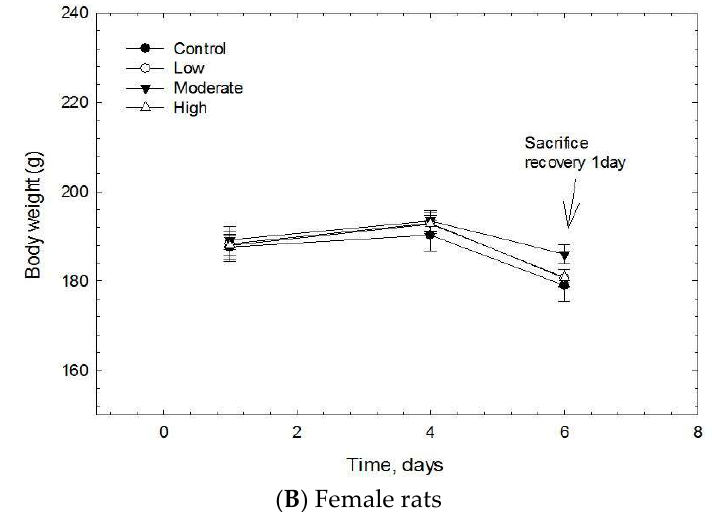
Figure 5. Changes in bodyweights of male rats during 5 days CNF exposure period and at 21 days post-exposure. ( A ), male; ( B ),